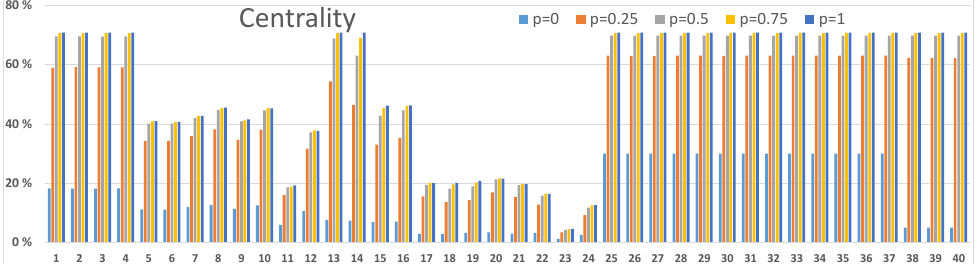
Figure 5. Centrality values of nodes in the network structure of Figure 1. Connections ab, ac, bc, ad, bd and cd between networks are functioning with resilience values p = 0,0.25,0.5,0.75 and 1. The results correspond to Figure